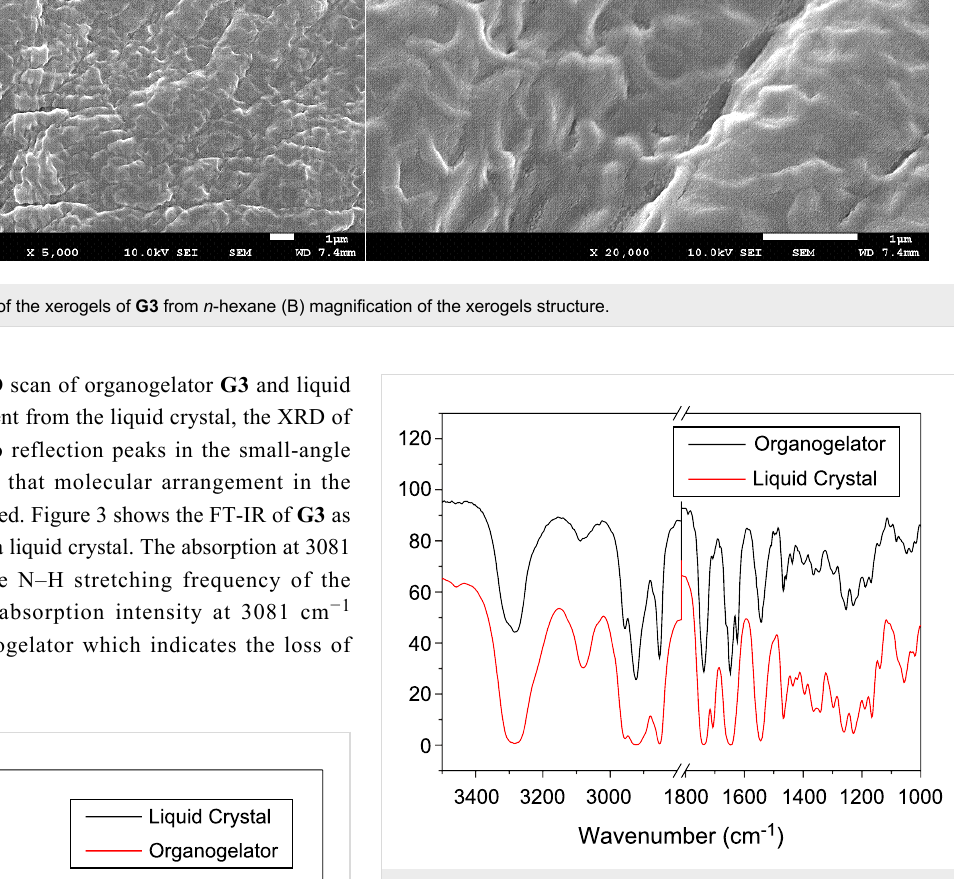
which hydrogen bonds form more easily. It is therefore reasonable that the minimum gelation concentration of G3 (1 wt %) was lower than G2 (3 wt %) in the same ( n -hexane)